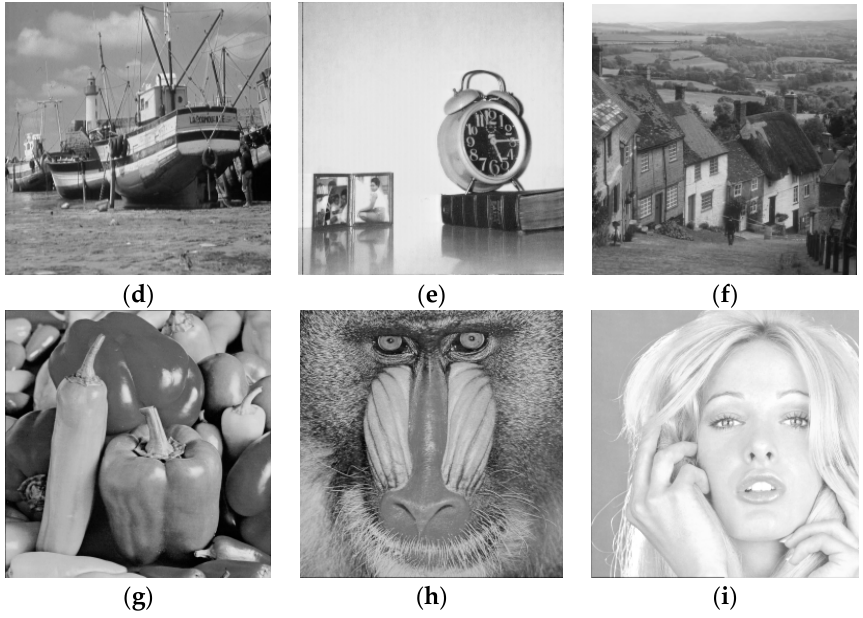
Figure 1. Images 256 × 256 pixels, 8.0 bpp. ( a ) Lena; ( b ) Barbara; ( c ) Elaine; ( d ) Boat; ( e ) Clock; ( f ) Goldhill; ( g ) Peppers; ( h ) Mandrill; ( i ) Tiffany.